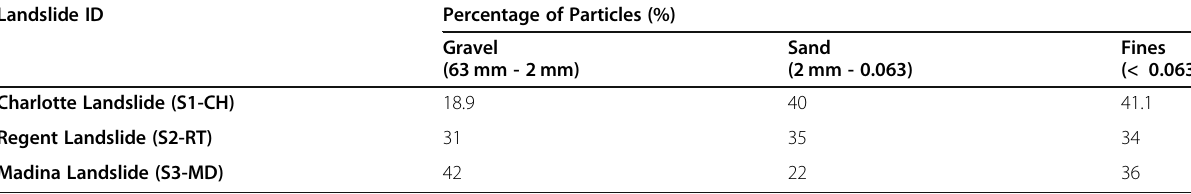
Table 2 Particle-Size distribution analysis on soil samples of the three landslides Landslide ID